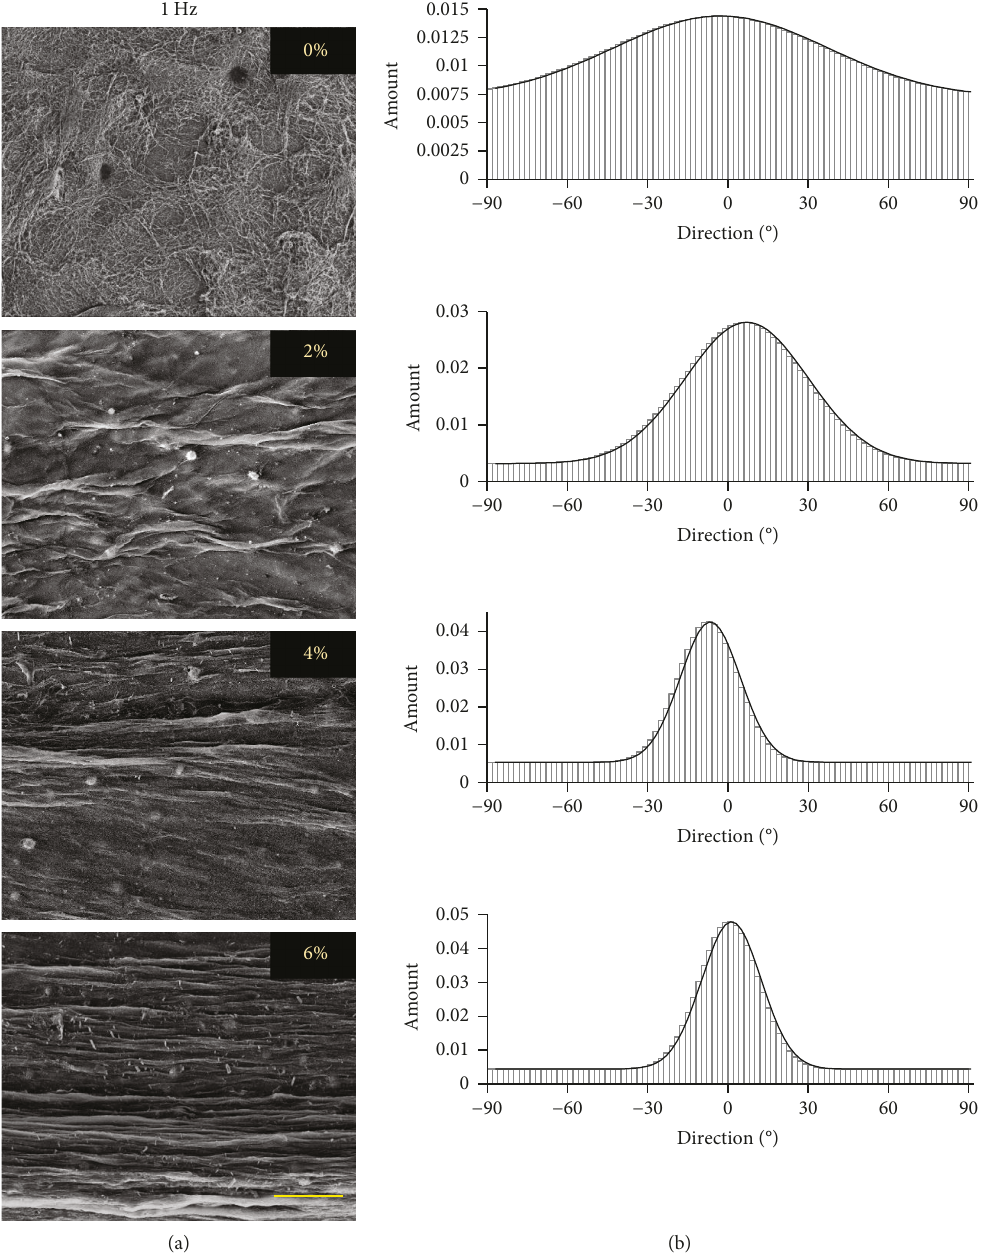
Figure 3: E ff ect of uniaxial tensile loading at 1 Hz frequency on matrix organization of ASC-encapsulated 3D collagen sca ff olds. (a) SEM images and (b) directionality histograms of ASC-seeded collagen constructs subjected to 7 days of uniaxial loading at 0%, 2%, 4%, and 6% strains at 1Hz frequency. Scale bar in the image represents 100 μ m. Sharper and higher peak in the histogram demonstrates a higher degree of orientation of the fi bers. The matrix orientation is parallel to the axis of tensile load